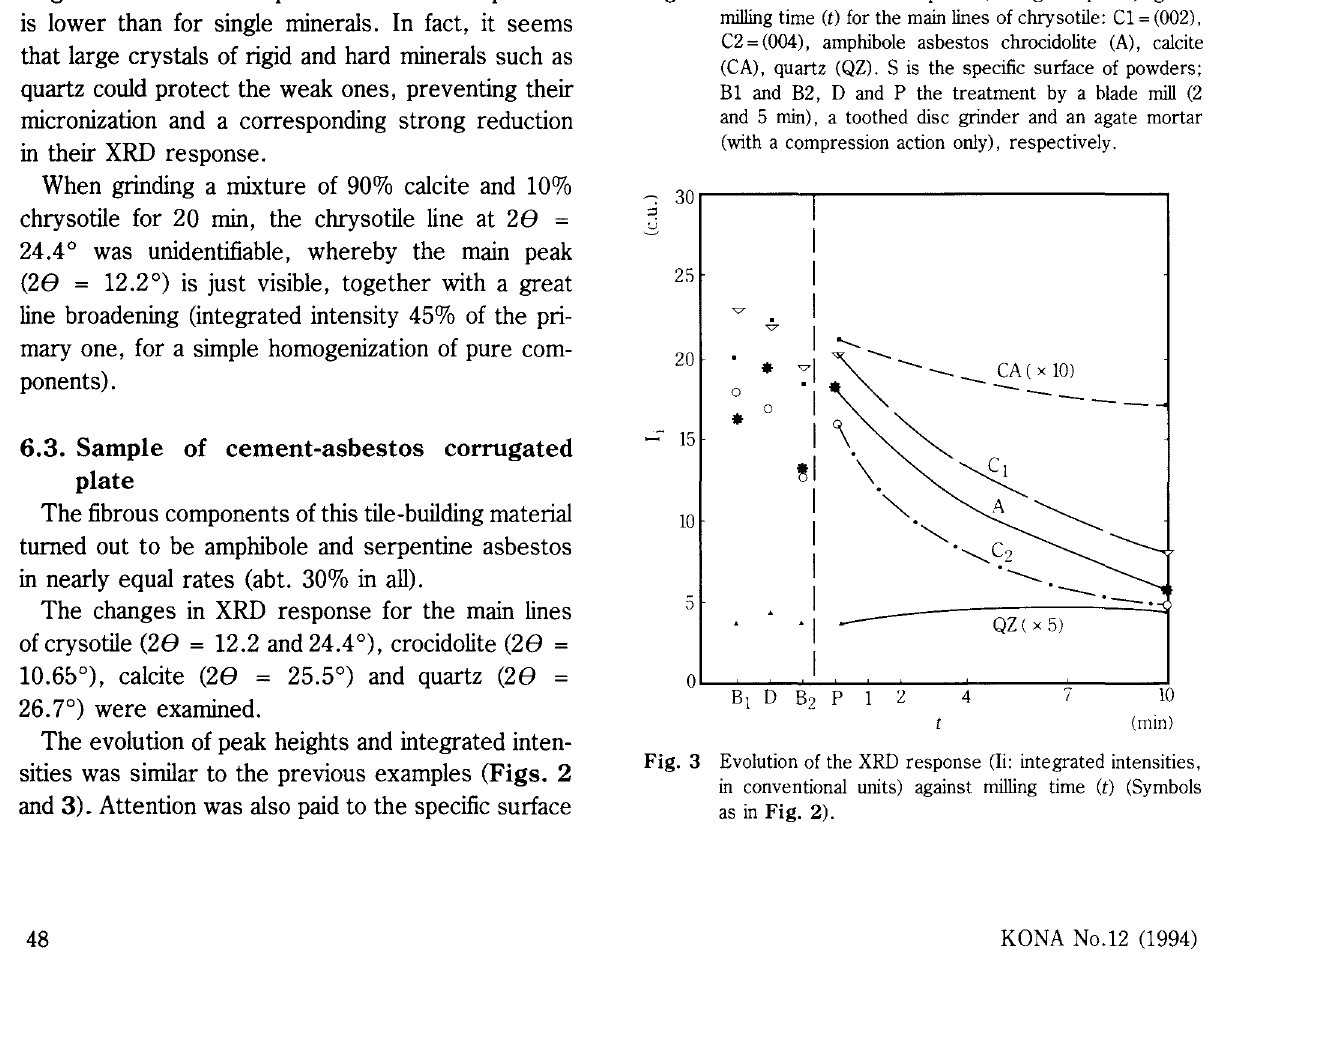
Fig. 2 Evolution of the XRD response (I: height of peaks) against milling time (t) for the main lines of chrysotile: Cl = (002), C2 = (004), amphibole asbestos chrocidolite (A), calcite (CA), quartz (QZ). S is the specific surface of powders; Bl and B2, D and P the treatment by a blade mi1I (2 and 5 min), a toothed disc grinder and an agate mortar (with a compression action only), respectively.